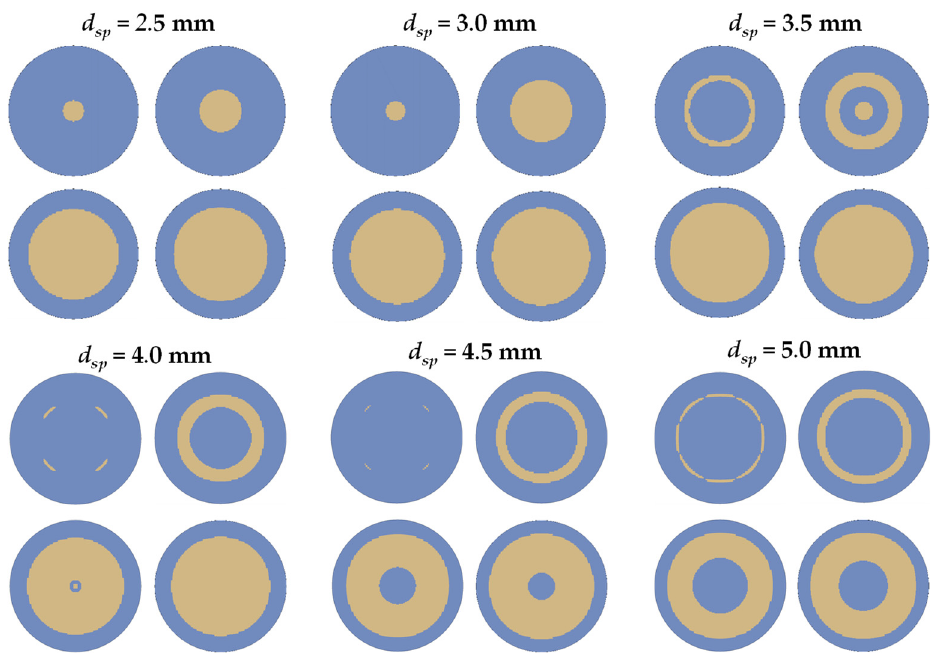
Figure 14. Predicted stripping evolution for different laser spot diameters. Aluminum’s thickness is 0.97 mm, epoxy’s thickness is 25 μ m and P max = 2639 MPa.